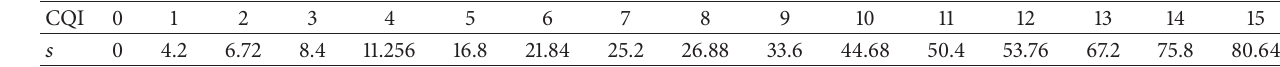
Table 1: CQIs and corresponding transmission rates